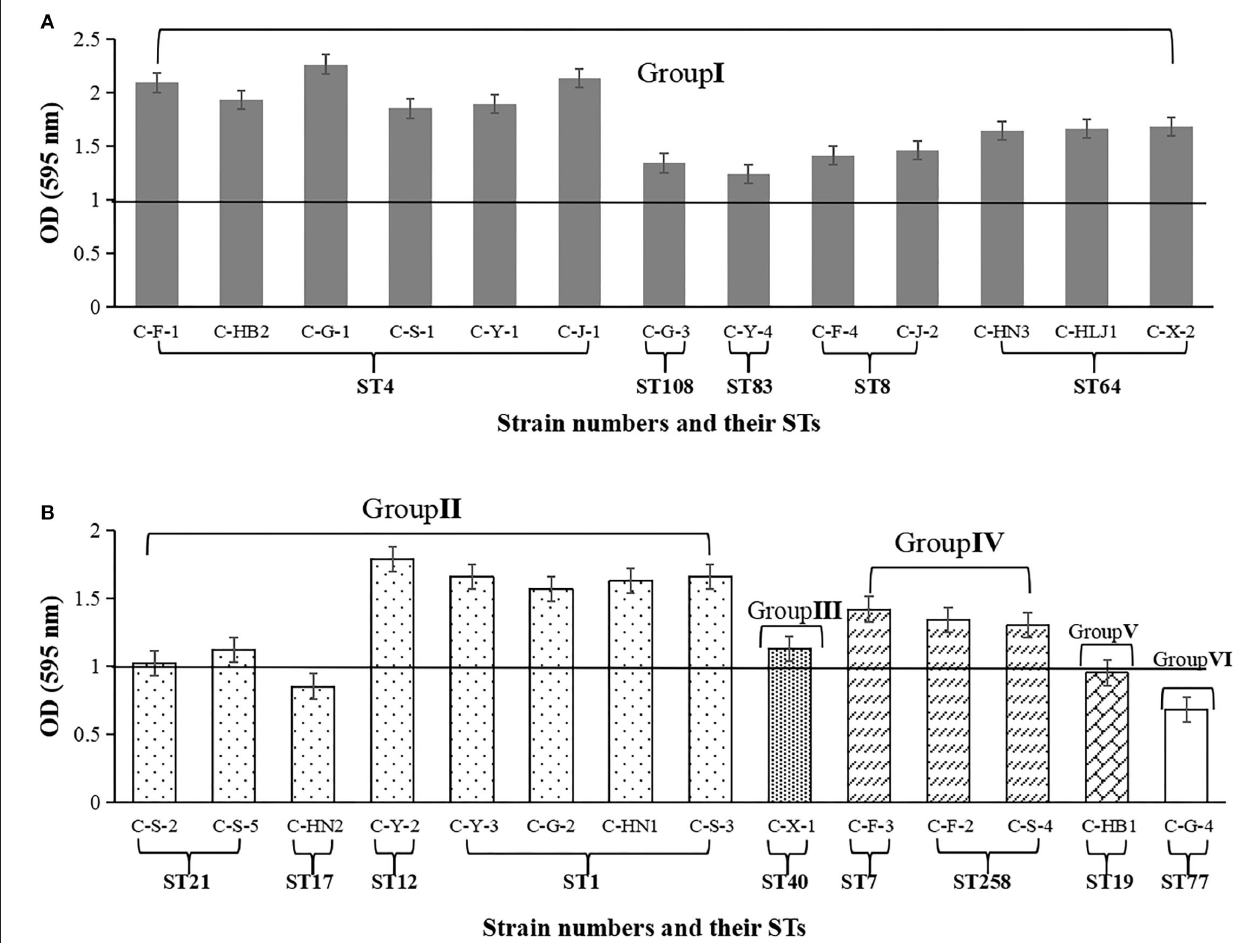
FIGURE 2 | Biofilm biomass formed by 27 Cronobacter isolates on tinplate. The OD value at wavelength of 595nm was used to indicate the biofilm biomass. (A) Cronobacter isolates belonging to group I. (B) Cronobacter isolates belonging to group II, group III group IV, group V, and group VI,